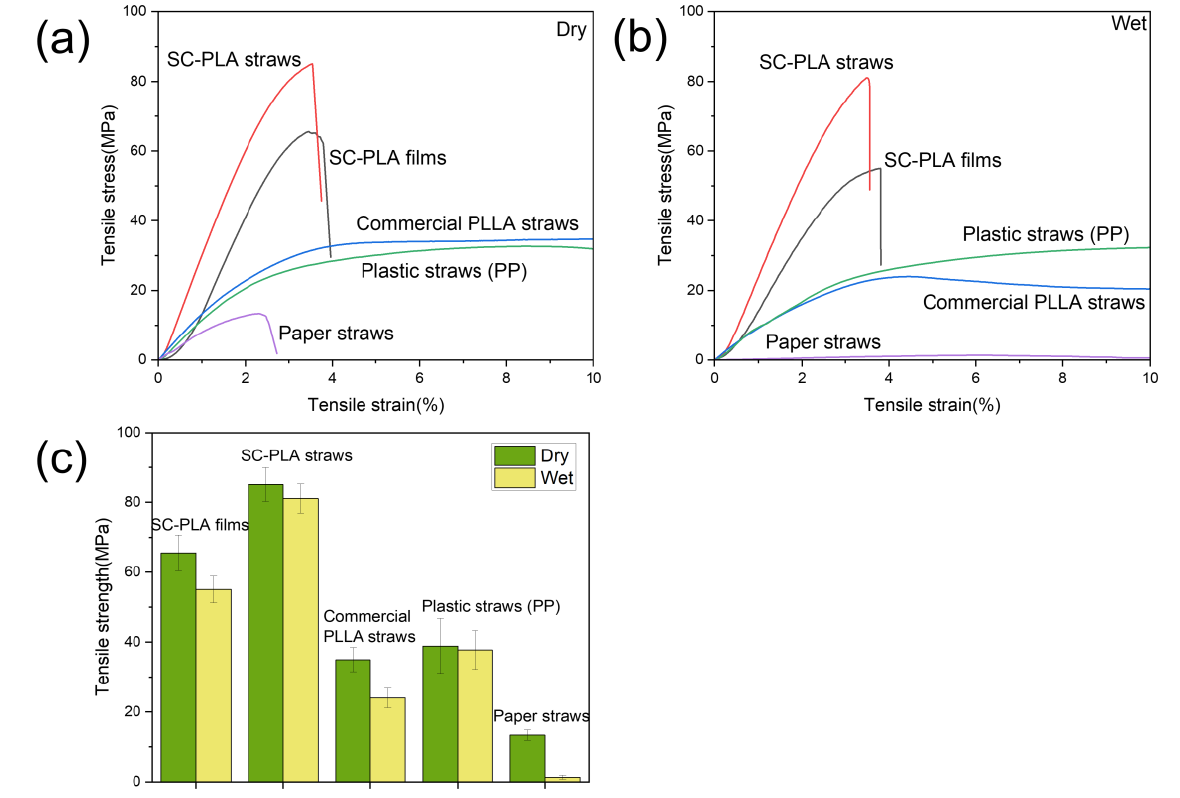
Figure 3. ( a ) Typical tensile stress-strain curves for all straws. ( b ) Typical wet tensile stress-strain curves for all straws immersed in hot water at 100 °C for 10 min. ( c ) Comparison of tensile strength of straws in different states.